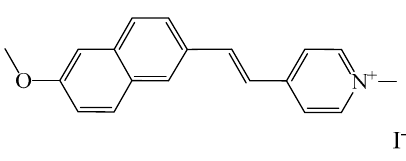
Figure 10. Molecular structure of ionic salts with naphthalene ring.